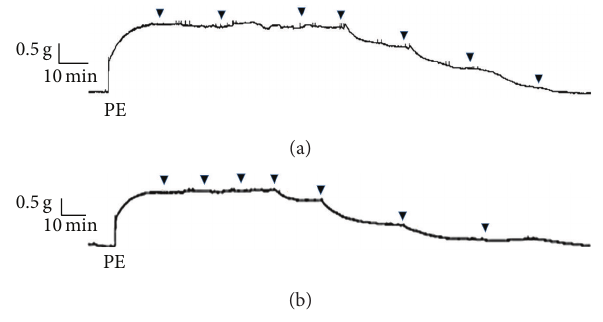
Figure 2: Representative original record of the effect of p -cymene on the isolated rat aortic rings contracted by phenylephrine with (a) and without (b) endothelium. The arrows represent the time-course of the p -cymene administration (10 −6 to 10 −3 M).